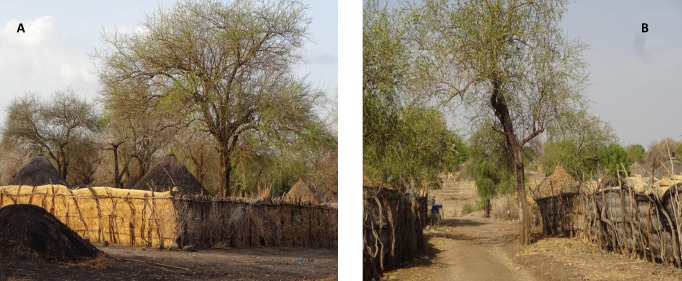
Images of typical household layout in VL endemic villages in Gedarif state, eastern Sudan (this example in Jebel-Algana study village).Each house consists of 2–4 thatched grass huts surrounded by a tall thatched reed fence that provides privacy. (A) Acacia and Balanites trees, associated with P. orientalis vectors, are commonly present within the property boundary, and (B) in the narrow earthen streets that separate household blocks. During the VL transmission season people sleep outside in within the household yard.